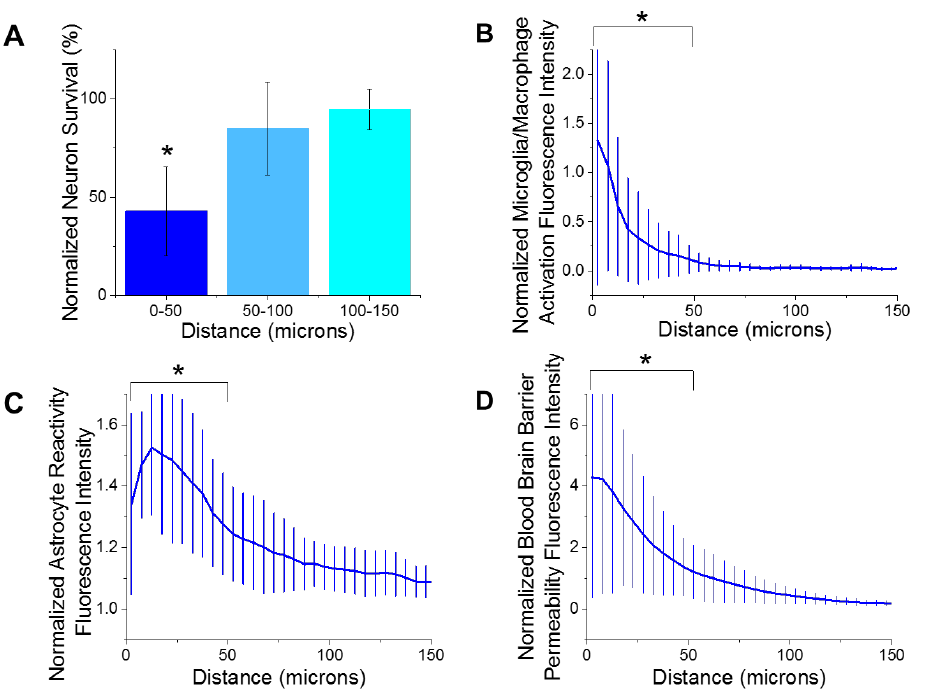
Figure 2. Histological metrics. ( A ) There was a significant decrease (* p = 0.000) of neuron density